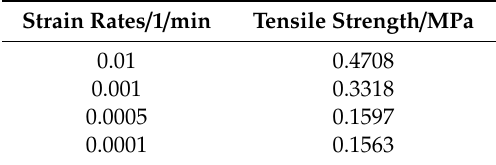
Table 4. Result of tensile test (voids content of